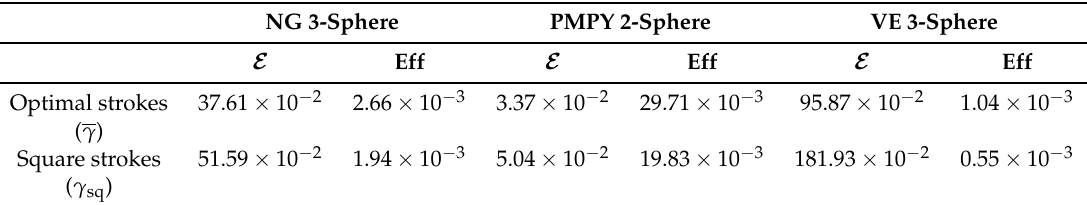
Table A4. Energy dissipation E ( γ ) and efficiency Eff of the optimal strokes γ and square strokes γ sq . All simulations are taken with X = 0.001 and ε =